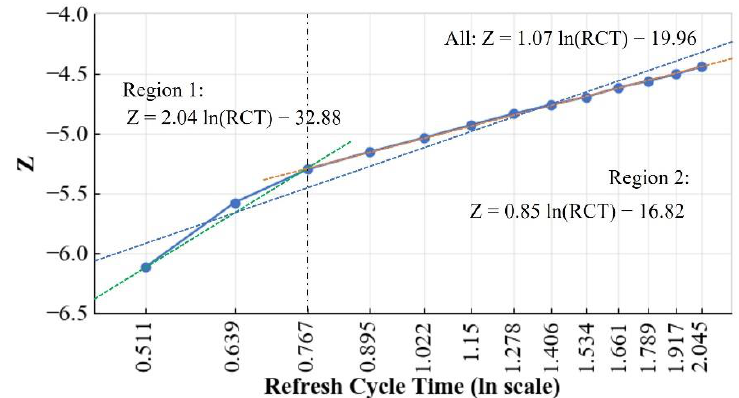
Figure 12. Z-value plot of retention errors with varying RCT in Pseudo channel 0 of Channel 0 at T L of 70 °C.